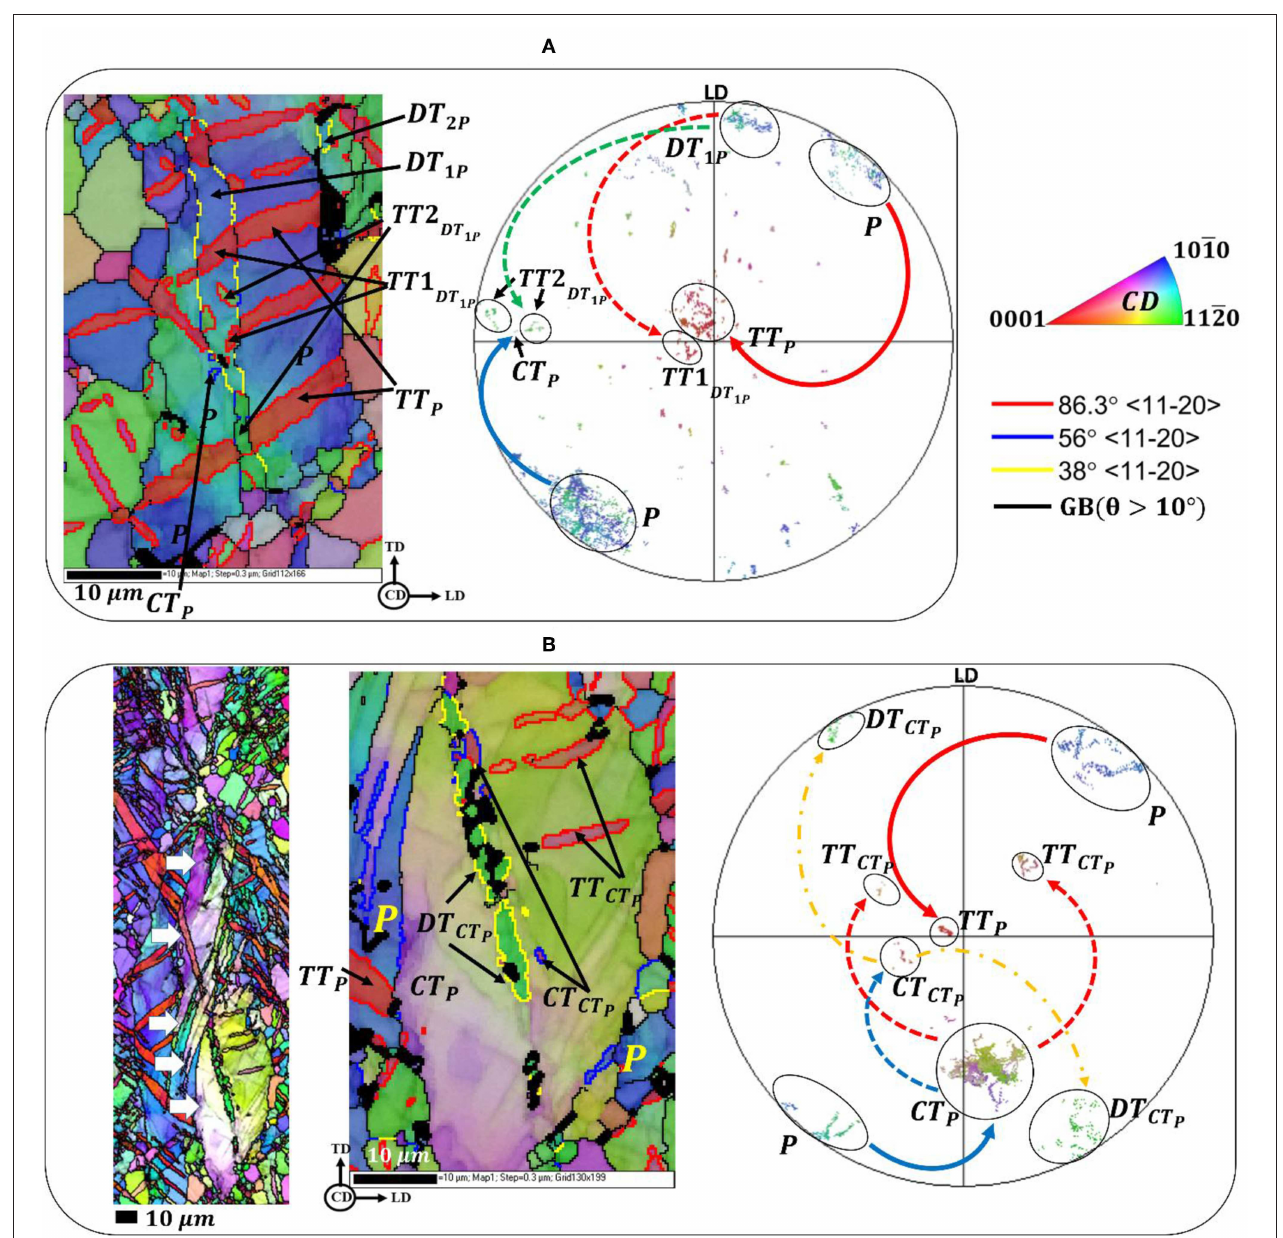
FIGURE 5 | Inverse pole figure maps and corresponding single orientation scatter data indicating different instances of hierarchically twinned structures comprising nested twins in ZEK110. The colored arrows in the single orientation scatter plots indicate the crystallographic rotation of the parent grains because of twinning. Grain boundaries larger than 10 are highlighted in black. Twin boundaries are shown as { 1012 } extension twins (highlighted in red), { 1011 } compression twins (blue) as well as { 1011 } − { 1012 } double twins (yellow). White arrows in left most image in (B) indicate the remnant sections of individual compression twins that nucleated next to each other and coalesce through dislocation slip to form a broad compression twinned